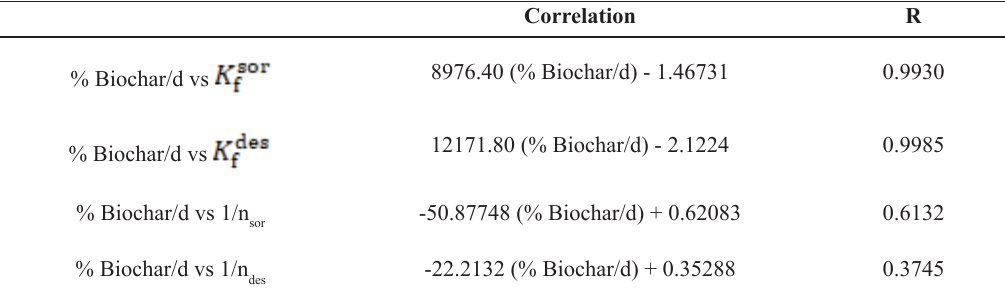
and 1/n sor des